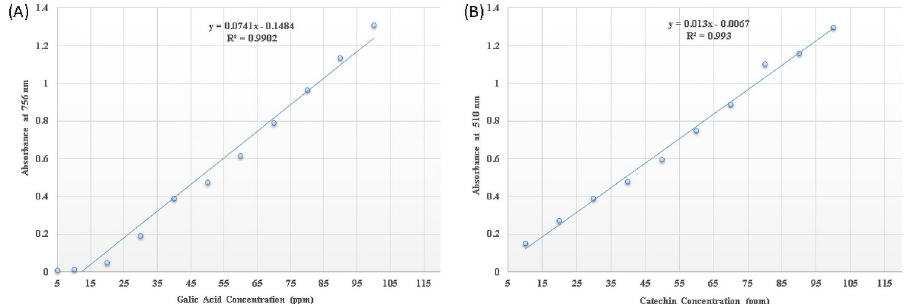
Fig 1. Representative standard curves for (A) total phenolic content; (B) flavonoid content.